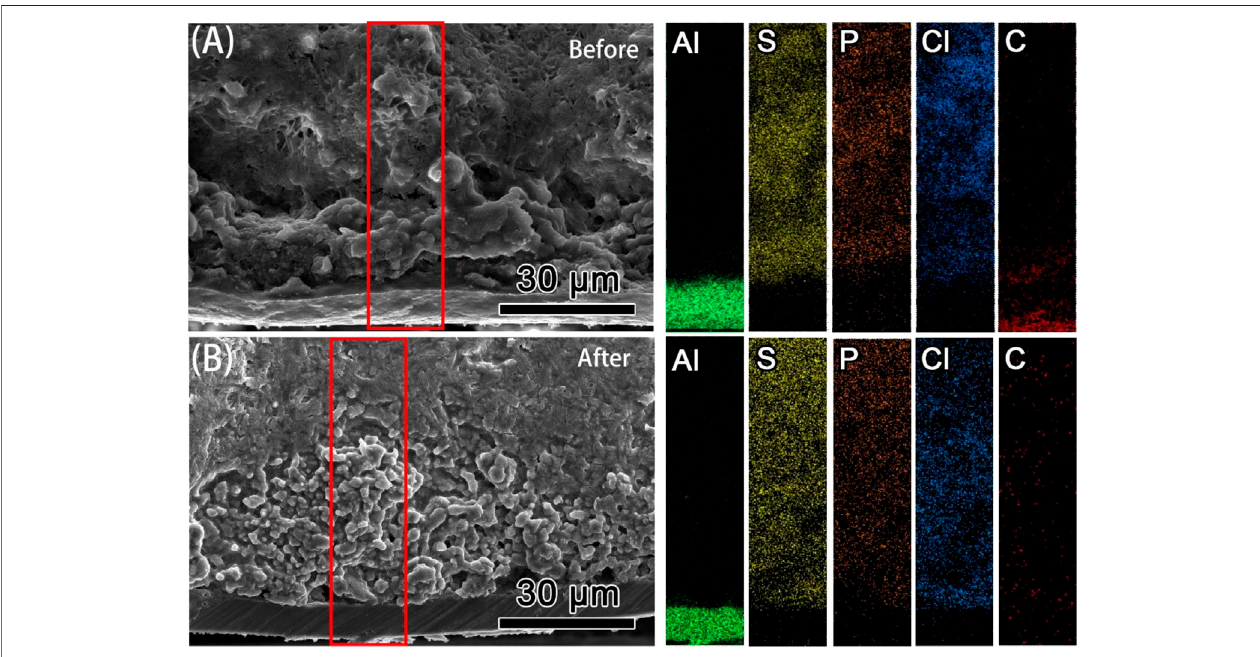
FIGURE 5 | The cross-sectional SEM images and the corresponding elemental mappings of the interface between Li 6 PS 5 Cl and sulfur-composite electrode (A) before cycling and after (B) 100 cycles at 80 mA g − 1 .